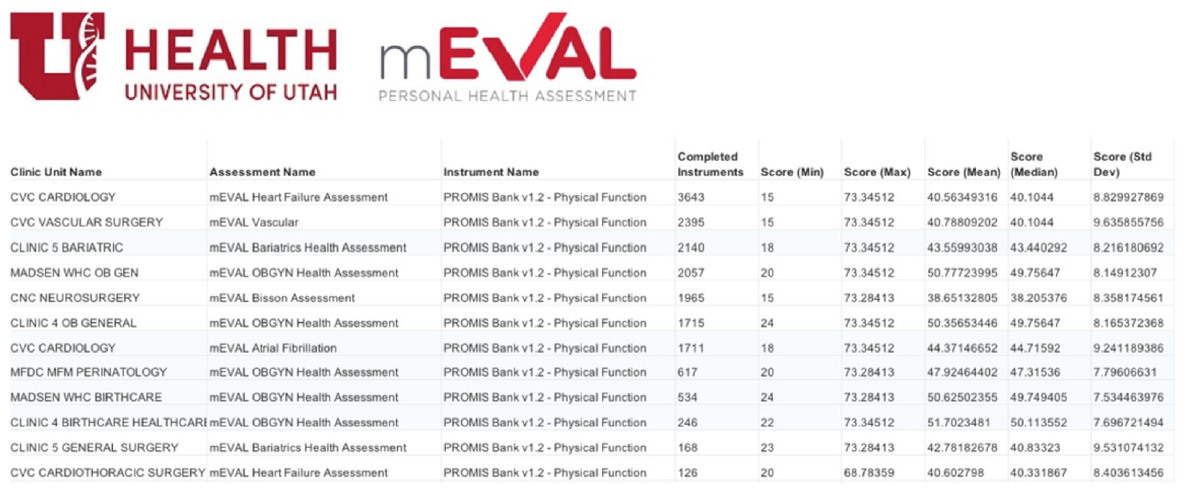
Fig. 2 Self-Service Portal Used by Providers to Compare PROs across